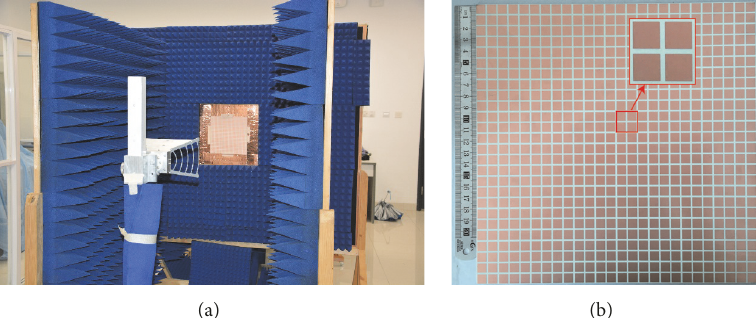
Figure 9: (a) Photograph of the measurement setup. (b) Photograph of the fabricated FSS.